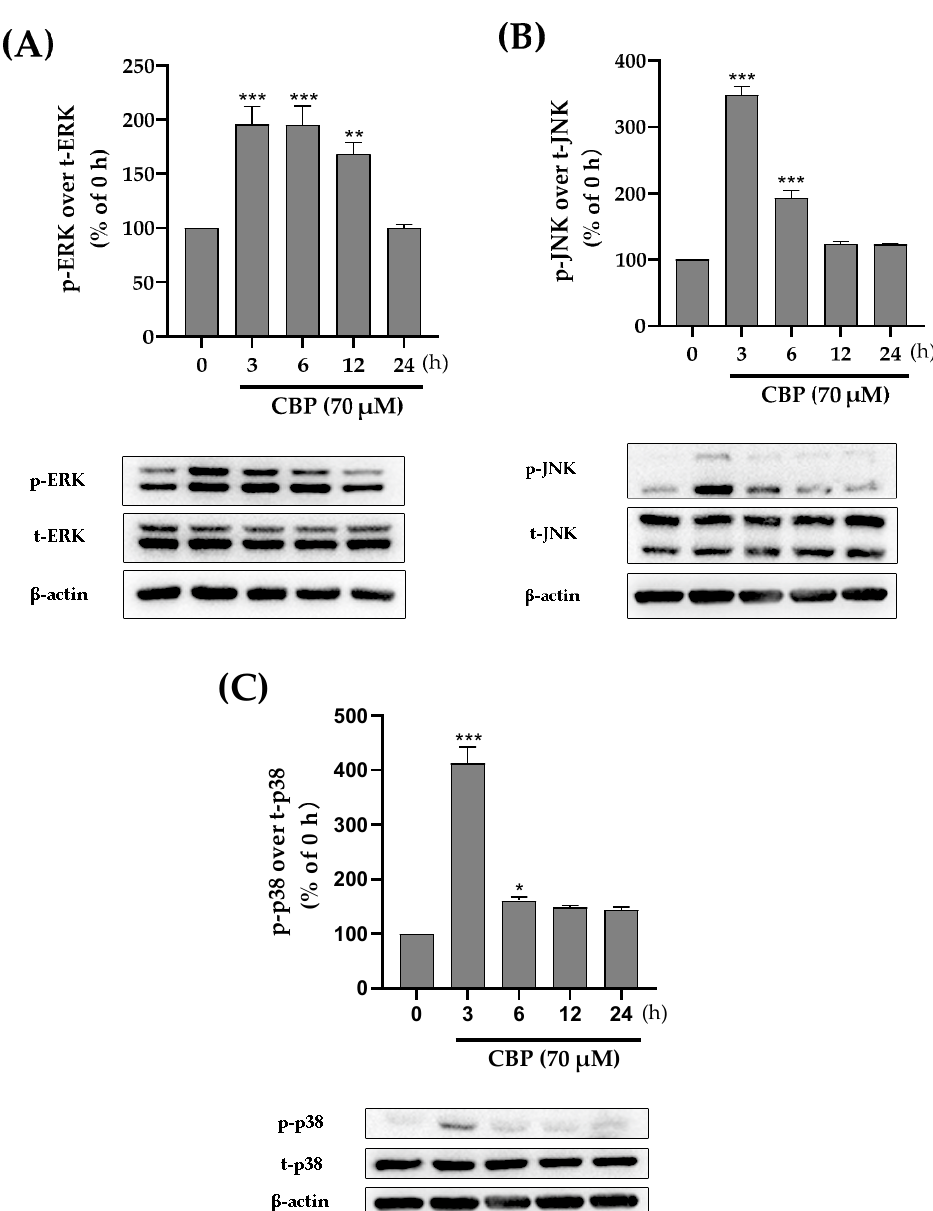
Figure 4. Effects of CBP on phosphorylation levels of ERK, JNK, and p-38 signaling pathways ex- pression. ( A ) Phosphorylation level of ERK signaling pathway in MC3T3-E1 cells cultured to 70 μ M